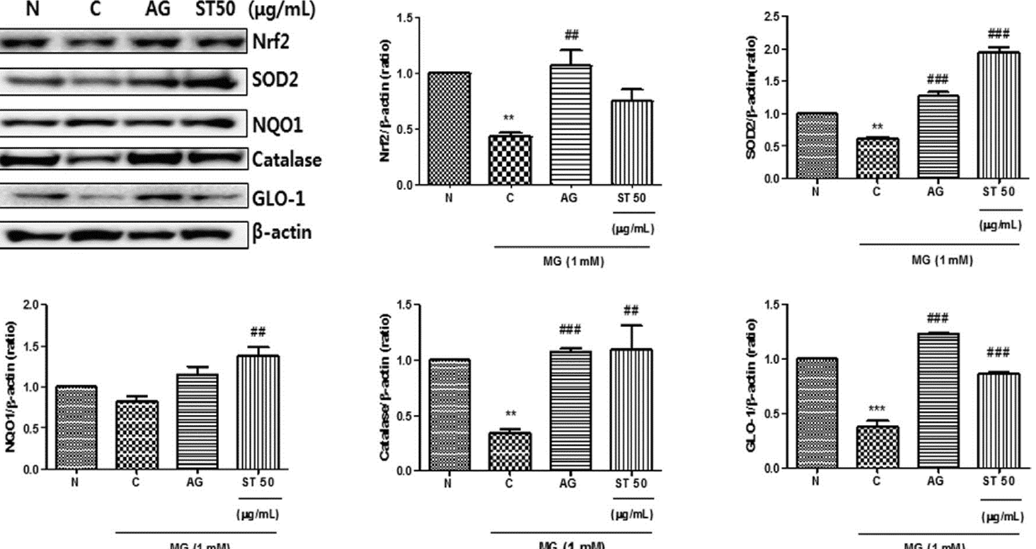
Figure 11. Effects of S. tenuifolia on the Nrf2/ARE pathway and GLO1 expression. The bar values are presented as mean ± SD of three independent experiments (** p < 0.01 and *** p < 0.001 vs. normal, ## p < 0.01 and ### p < 0.001 vs. control) (from Figure 5 in [31]).